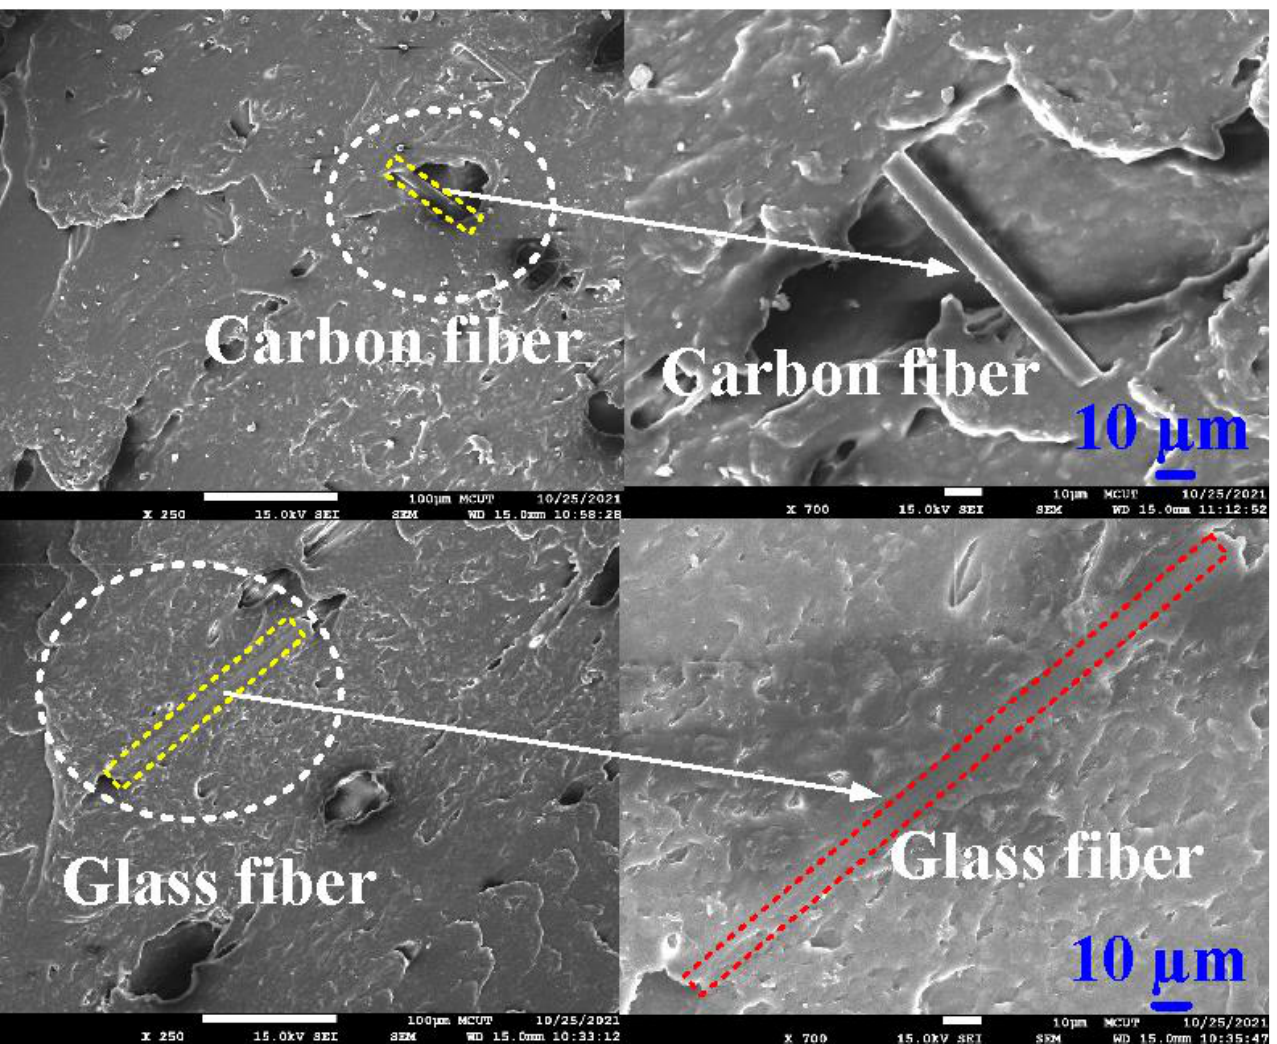
Figure 13. FE-SEM images of 10 wt.% glass fiber-reinforced PLA and 10 wt.% carbon fiber-reinforced PLA.